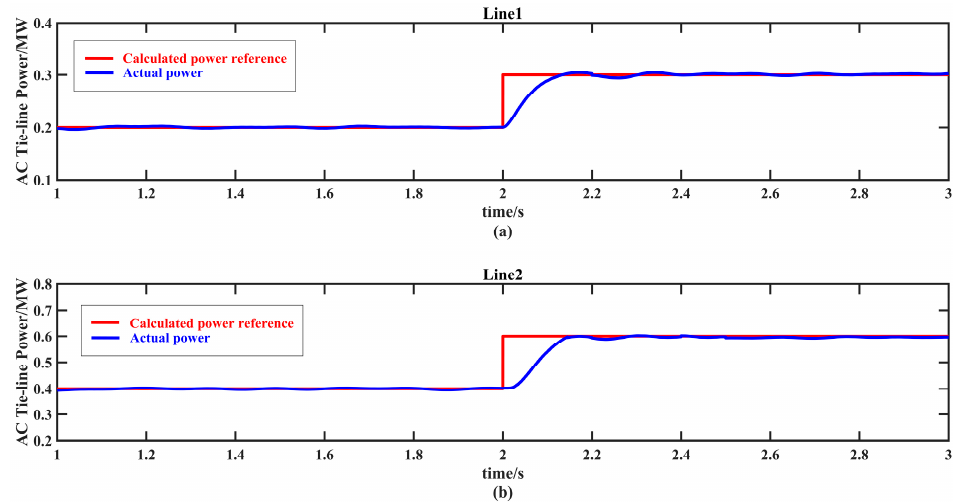
Figure 7. Calculated and actual AC tie-line power. ( a ) AC tie-line 1; ( b ) AC tie-line 2. Table 4. Operation indexes during the normal operation of the HESS.